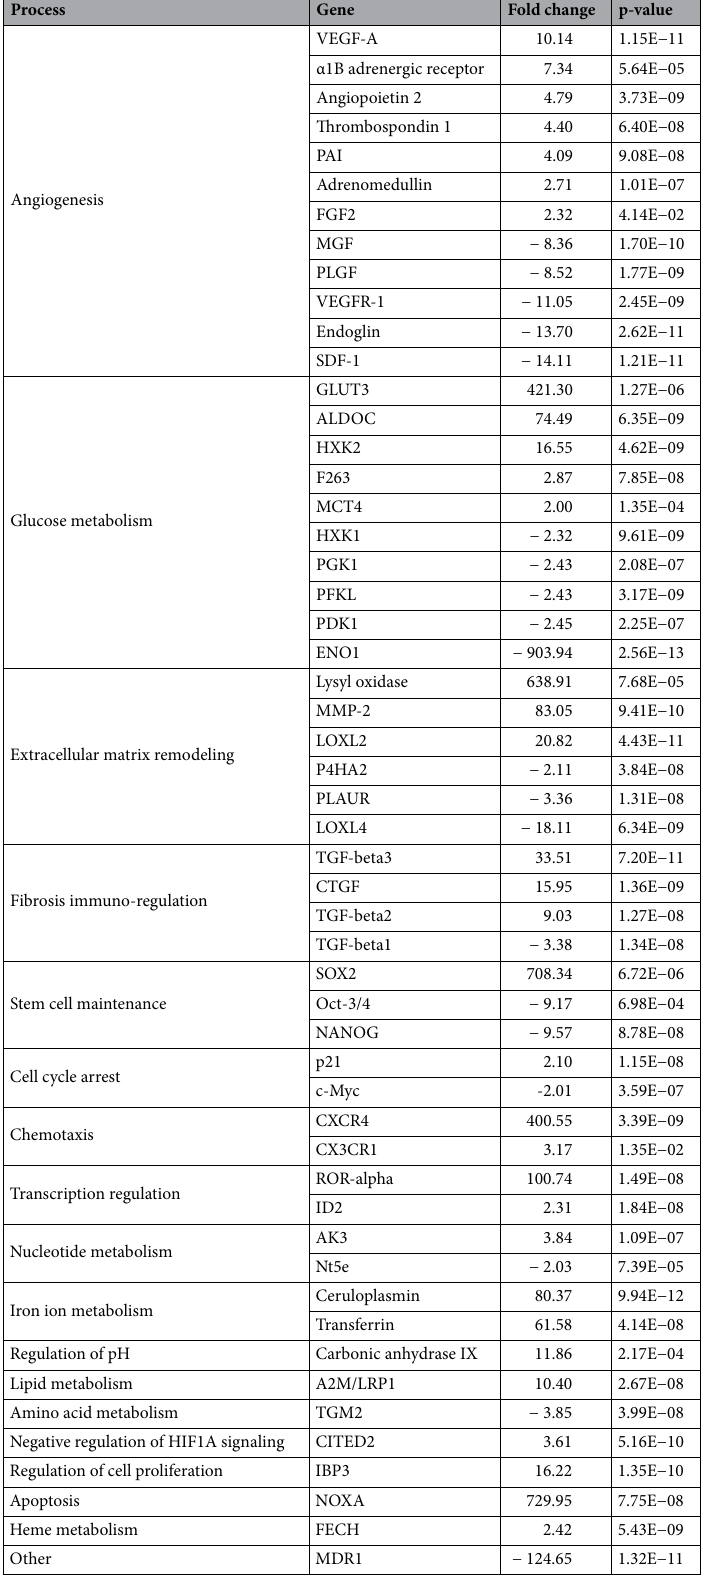
Table 1. Differentially expressed genes in the “transcription: HIF-1 targets” pathway. List of transcripts DEG sorted by process and fold change, with respective p-value when compared PVEC vs.